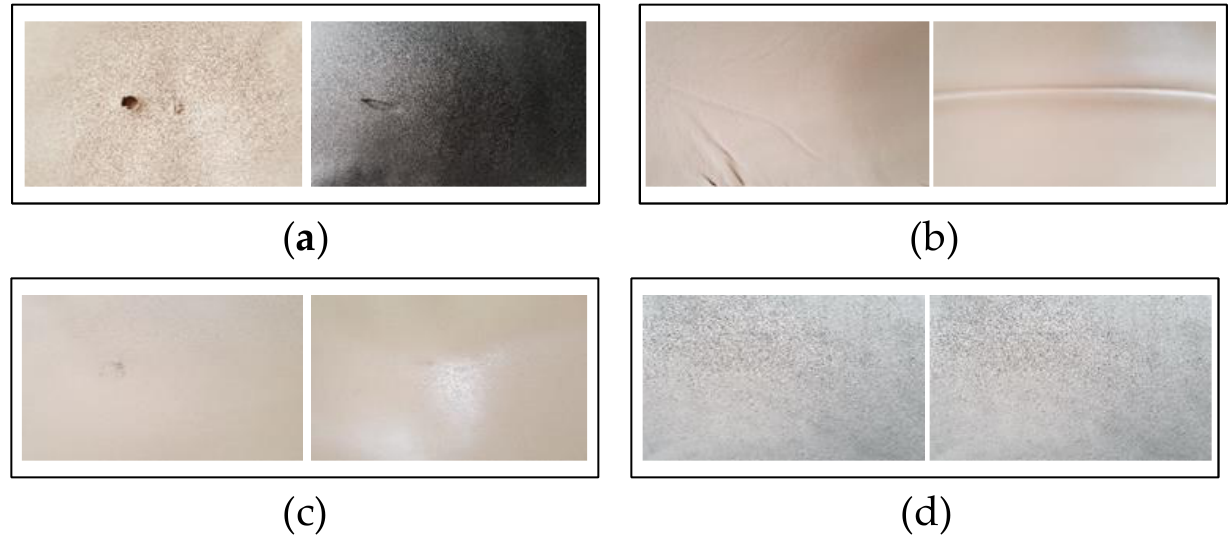
Figure 3. Four different leather defects: ( a ) hole; ( b ) wrinkle; ( c ) healing wound; and ( d ) needle eye. Table 1. The detected results by using edge detectors.